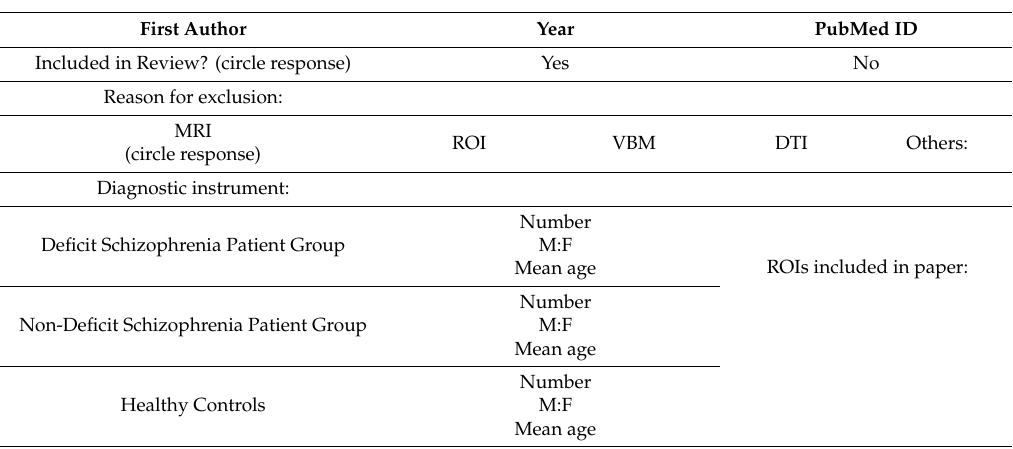
Table A1. Data extraction